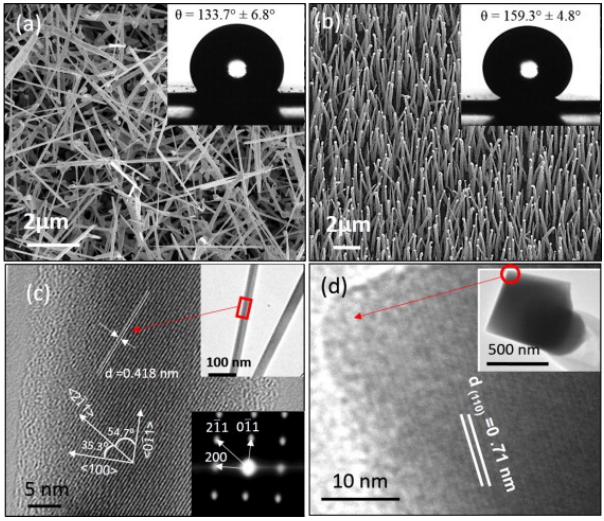
Figure 16. FESEM images of ( a ) randomly distributed and ( b ) vertically aligned IO nanorods. The insets show the contact angle images of the respective samples. HRTEM images of ( c ) randomly distributed and ( d ) vertically standing IO nanorods. The insets show the TEM and SAED pattern of respective nanorods [44].